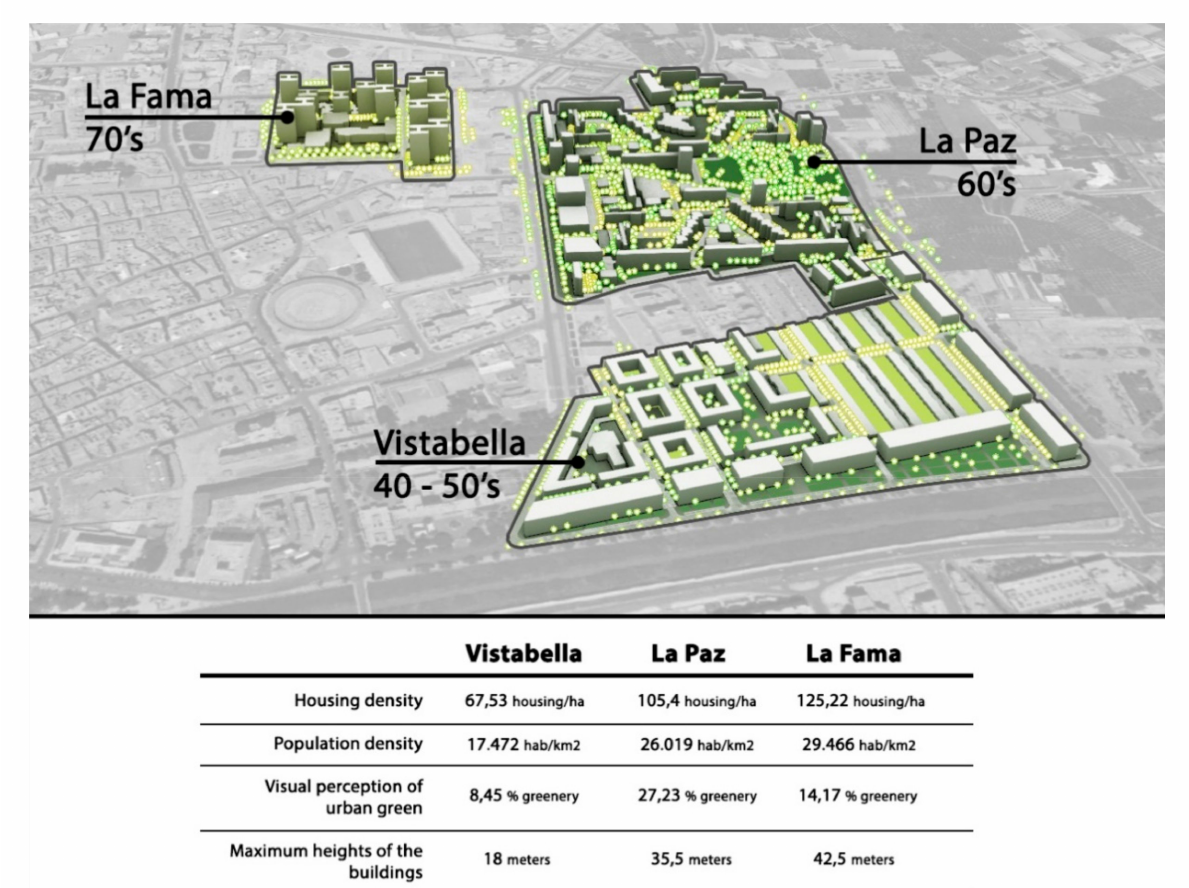
Figure 1. Aerial view of the three neighborhoods. Authors’ image based on orthophoto 1981_CARM. Source: Visorid- erm